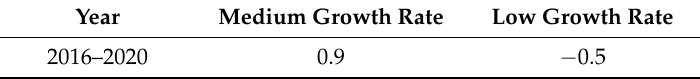
Table 5. Resident population growth rates of Beijing form 2016 to 2020 (%).